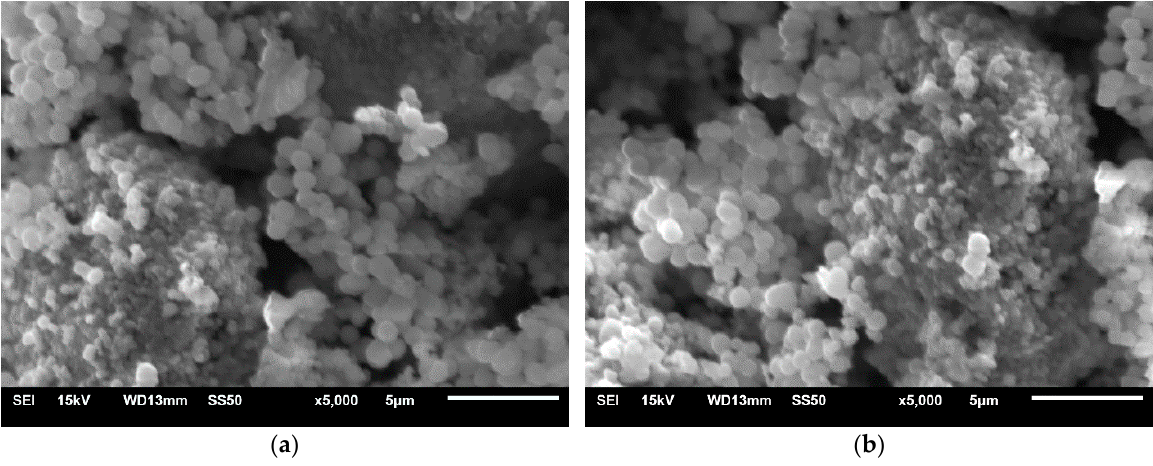
Figure 8. SEM micrographics of modified SEM Fe 3 O 4 NPs: ( a ) 5000 times, ( b ) 5000 times.